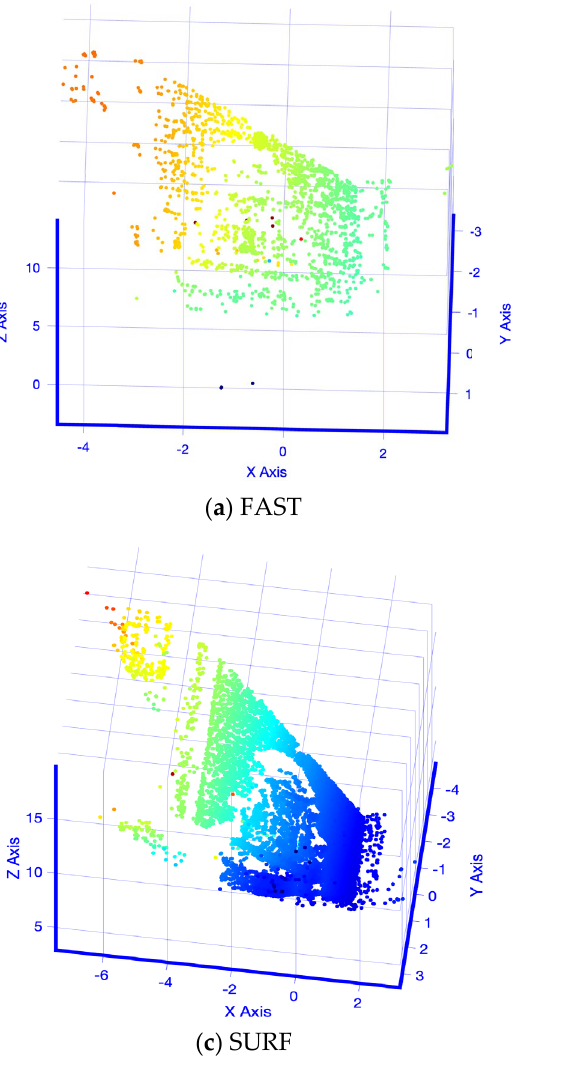
Figure 11. Sparse Reconstruction. FAST ( a ), ORB ( b ), SURF ( c ) and this study’s multi ( d